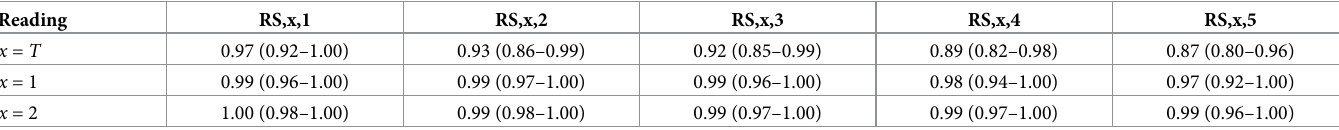
Table 2. Specificity of each interpretation of the reagent strip RS , x , z defined as a result of at least x ( x being T for trace, 1, or 2), on the first z days. Values are given between 0 and 1, where 1 corresponds to zero probability of a false-positive, values in brackets represent the 95% Bayesian credible interval.